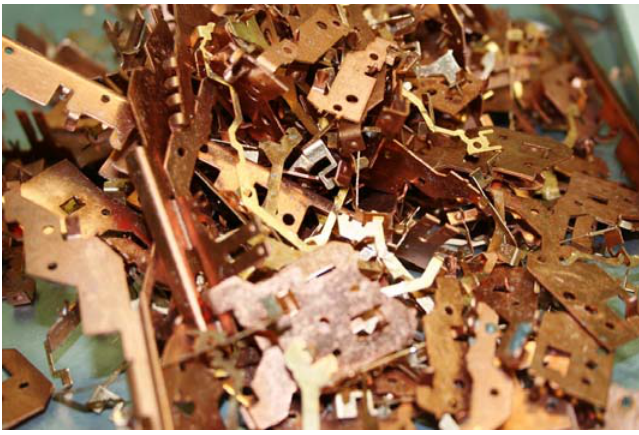
Figure 6. Recovered copper parts from CreaSolv ® Process.